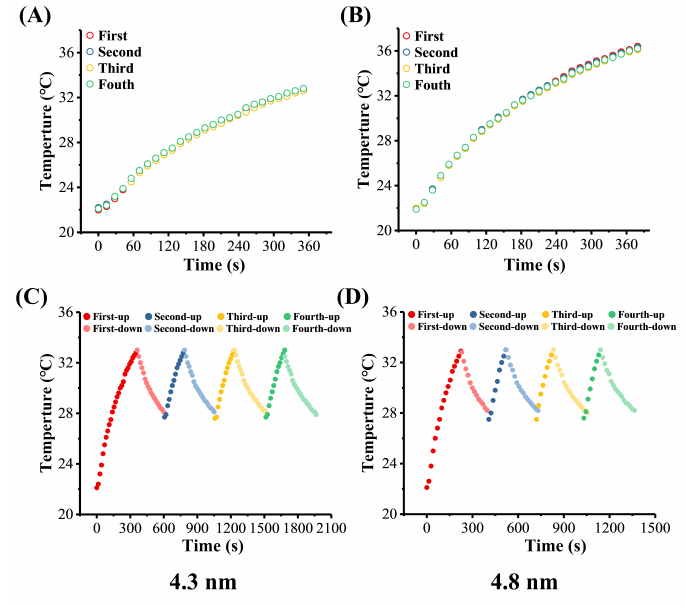
Figure 5. Repeatability of heating e ffi ciency of the MHFn in aqueous under AMF treatment. ( A,B ) Single measurement of temperature rise for four times for 4.3 and 4.8 nm samples, respectively. ( C,D ) Continuous measurement of temperature rise on heating to 33 ◦ C and cooling to 28 ◦ C for four cycles. All the measurements were performed at c = 5 mg[Fe] / mL, magnetic field H = 19.5 kA / m and f = 805.5